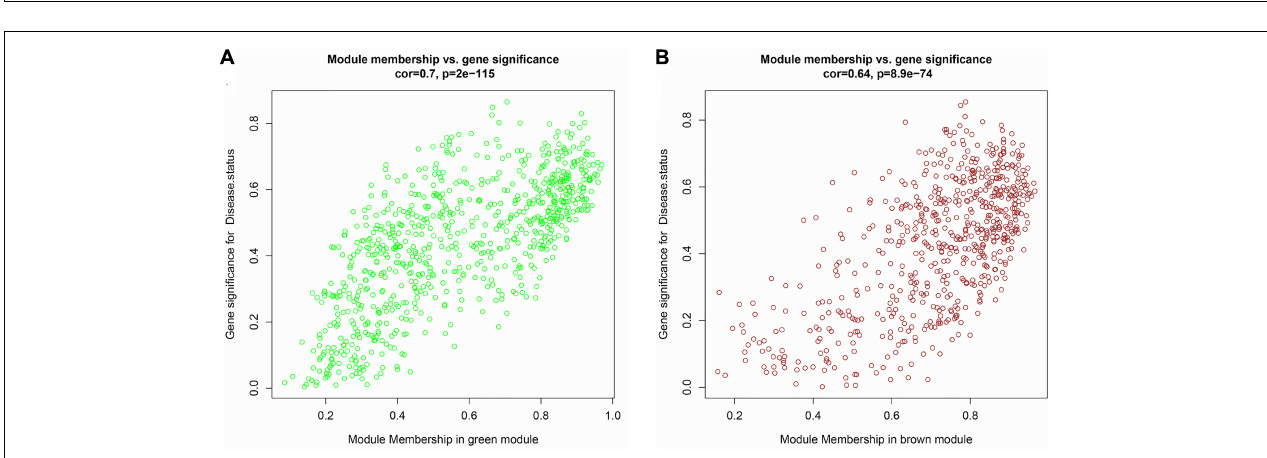
FIGURE 2 | Construction of co-expression network. (A) Sample clustering analysis based on GSE15197. (B) Analysis of network topology for various soft-thresholding powers. (C) Clustering dendrogram of genes. Genes with similar expression patterns divided into same module. Each line of hierarchical clustering represents one gene. (D) Module–trait associations. Each cell contains the corresponding correlation and P- value.